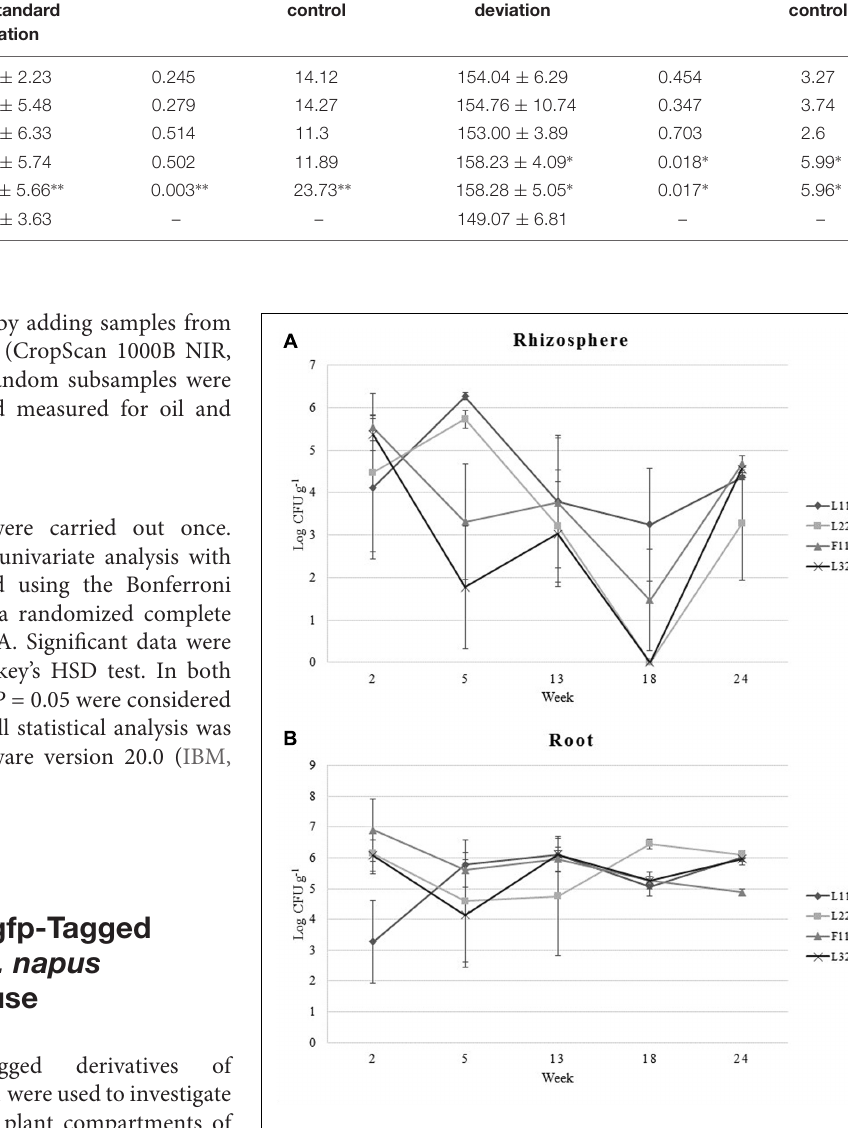
TABLE 2 | Summary statistics from the field trial of B. napus inoculated with plant growth promoting Pseudomonas and a bacterial consortium (MM). Treatment Sample size ( n )